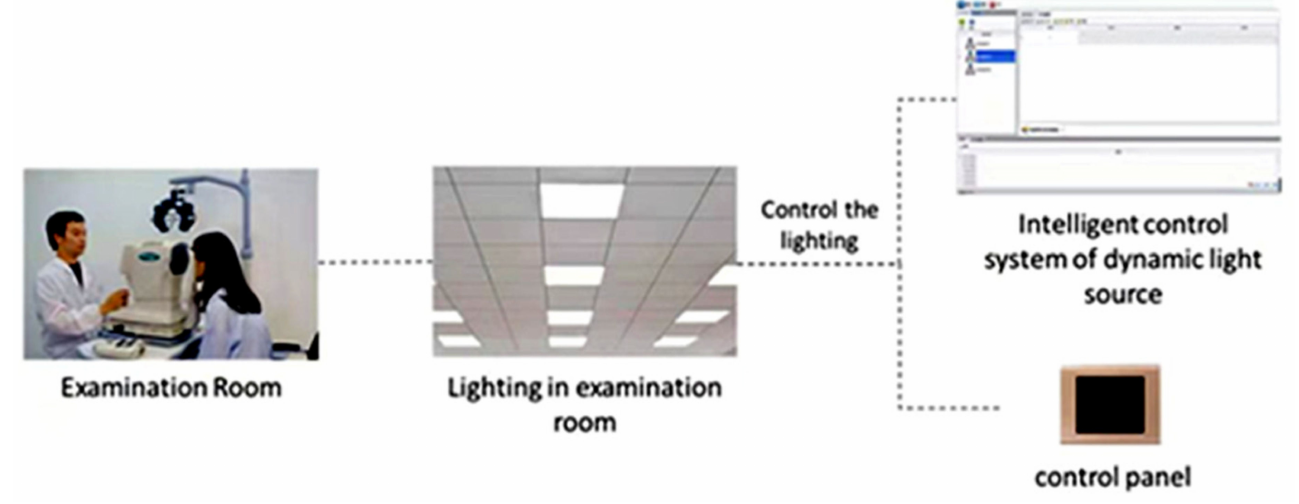
Figure 1. Examination room and intelligent control system of dynamic